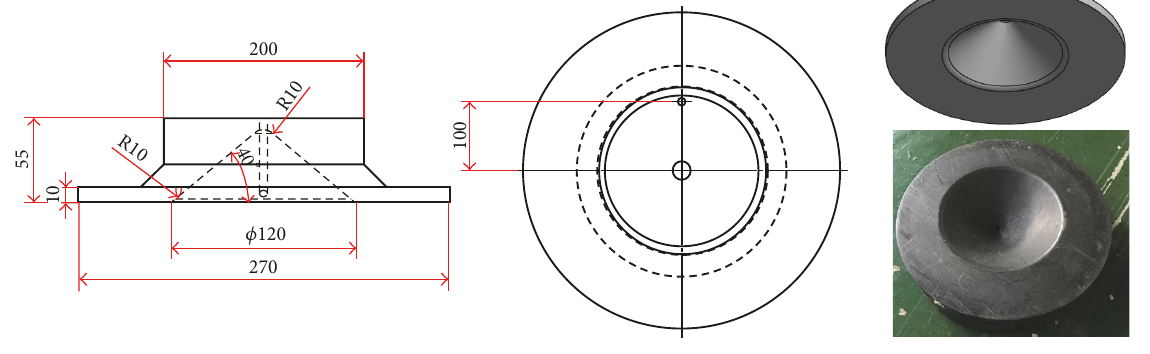
Figure 2: Die for EHF.